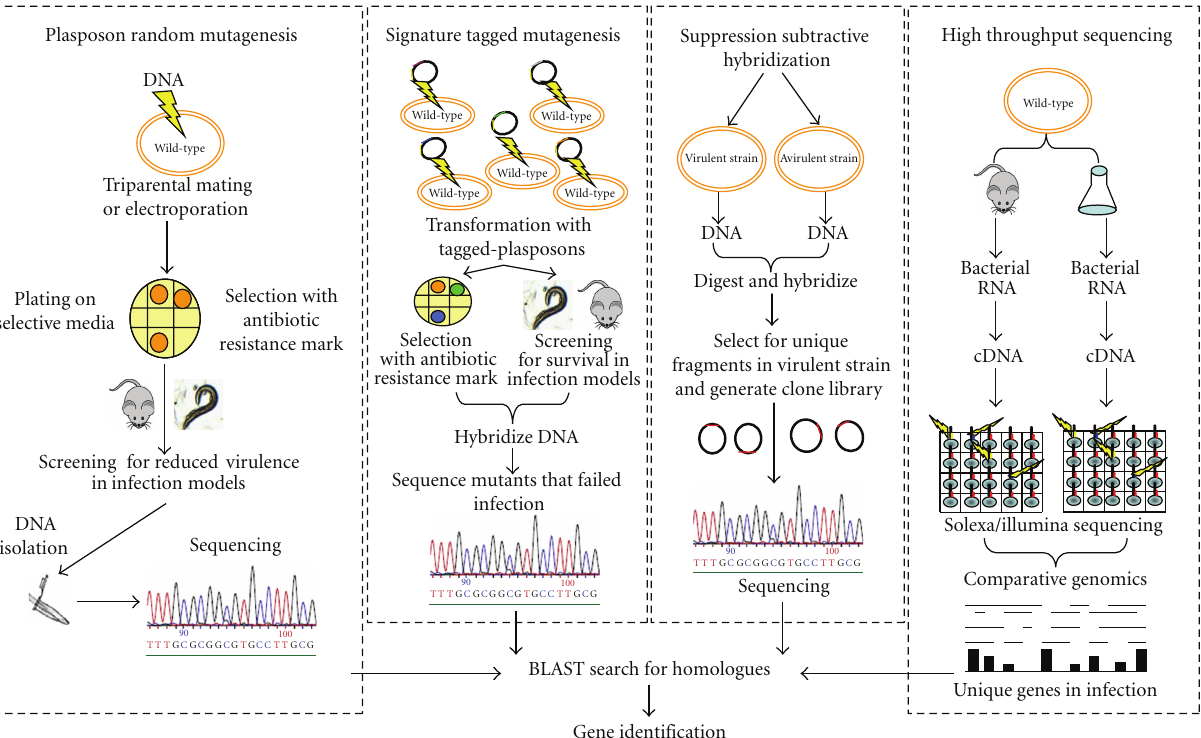
Figure 1: Strategies used to identify Bcc virulence factors and